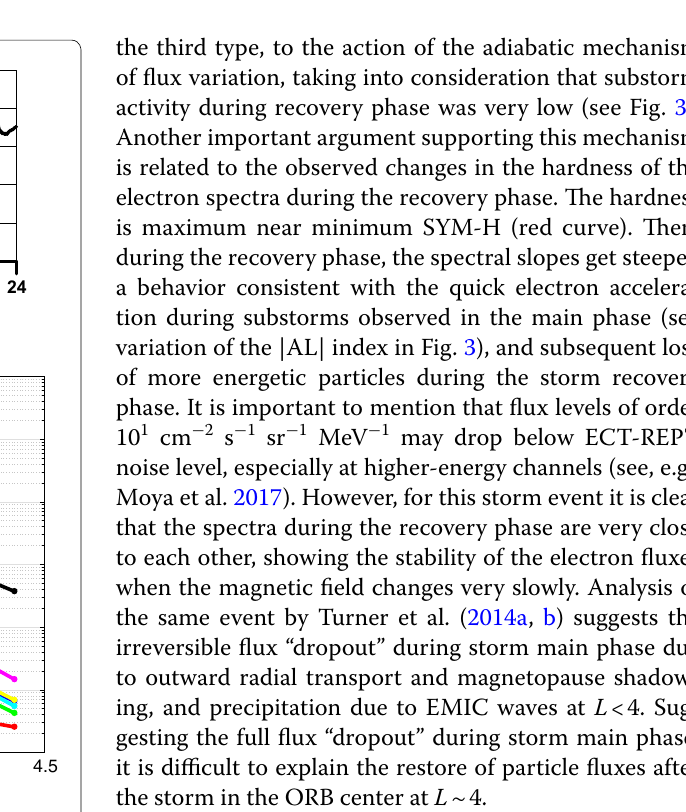
Fig. 5 a SYM-H for the 1 October 2012 geomagnetic storm. Vertical color lines indicate the time of measurements of electron fluxes shown in Fig. 4b. b Differential electron particle fluxes measured by the ECT-REPT instrument onboard the RBSP-A ( a ). Colors correspond to the times of measurement indicated in Fig.